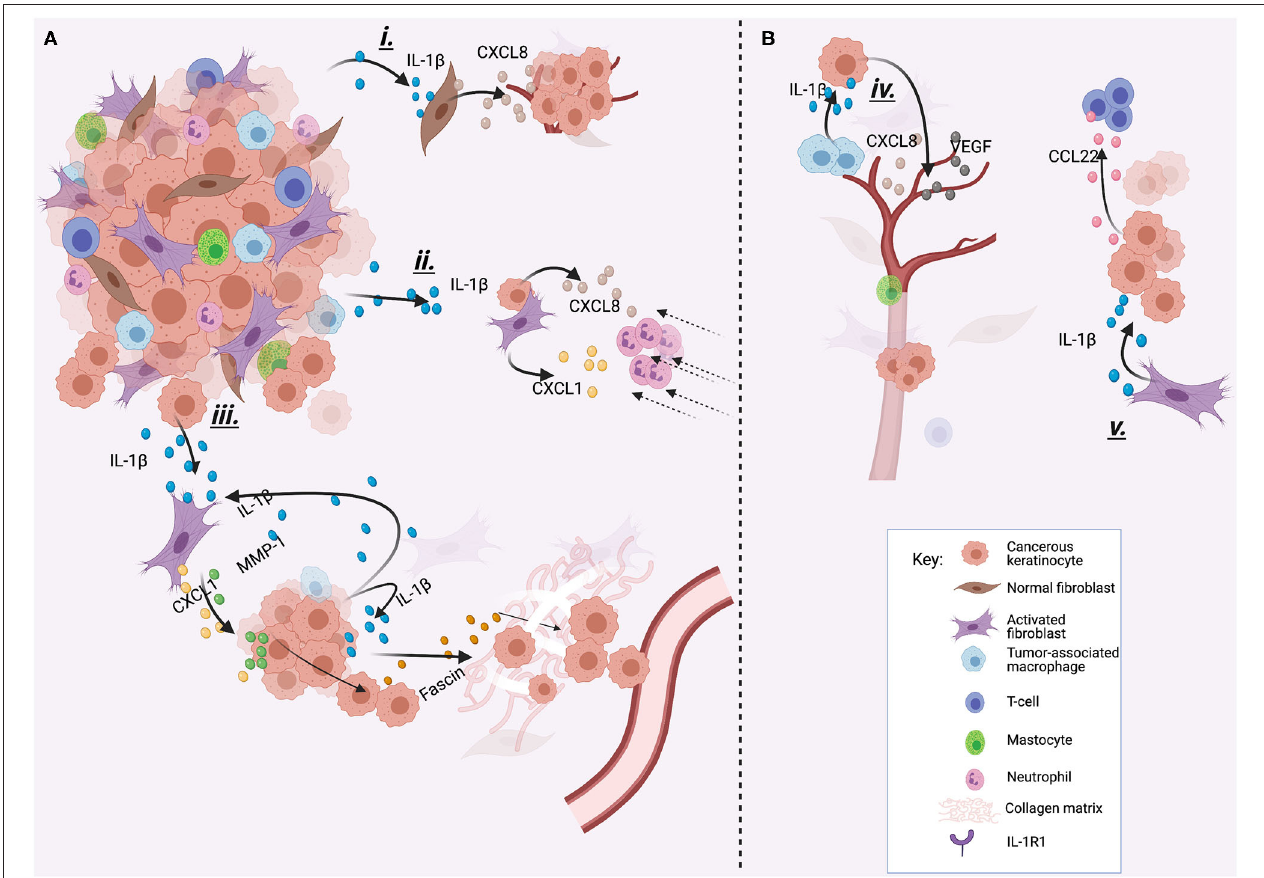
FIGURE 3 | Different examples of how IL-1 β can promote cancer progression. IL-1 β can be produced by tumor cells (A) or by other cells of the TME (B) . (i) IL-1 β produced by tumor cells stimulates CXCL8 release from normal oral fibroblasts, which increases tumor growth. (ii) IL-1 β stimulates CXCL1 and CXCL8 production by CAFs and tumor cells which attracts neutrophils to the TME, and neutrophil accumulation has been related with poor outcome in HNSCC. (iii) IL-1 β released by tumor cells induces CXCL-1 and MMP-1 secretion by CAFs. This induces invasion and migration of cancer cells. Also, secreted IL-1 β can act in a paracrine way inducing fascine release, which helps in the degradation of the extracellular matrix and invasion. (iv) TAMs produce IL-1 β to stimulate cancerous cells to produce VEGF and CXCL8, inducing angiogenesis. (v) IL-1 β produced by CAFs induces the release of CCL22 by tumor cells, which recruits T regulatory cells, who have been associated with worse prognosis. This image was created with